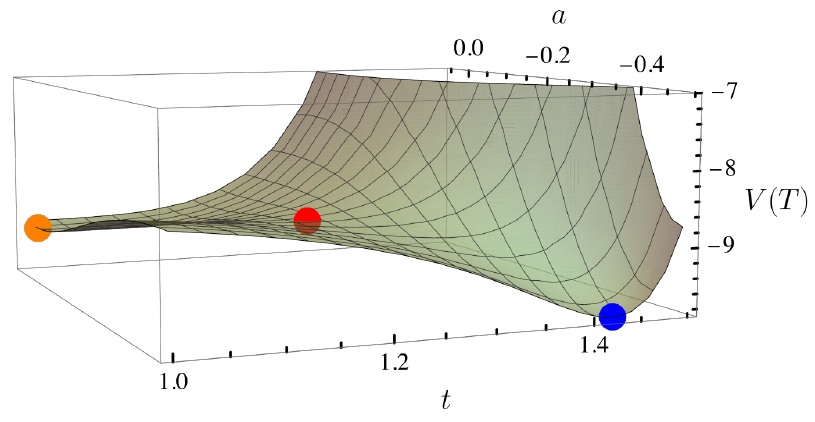
Figure 5 . Potential with two minima and a saddle interpolating between them. The orange dot is a minimum at T = i , the blue dot is a minimum on the line Re ( T ) = − 1 the saddle point inside the fundamental